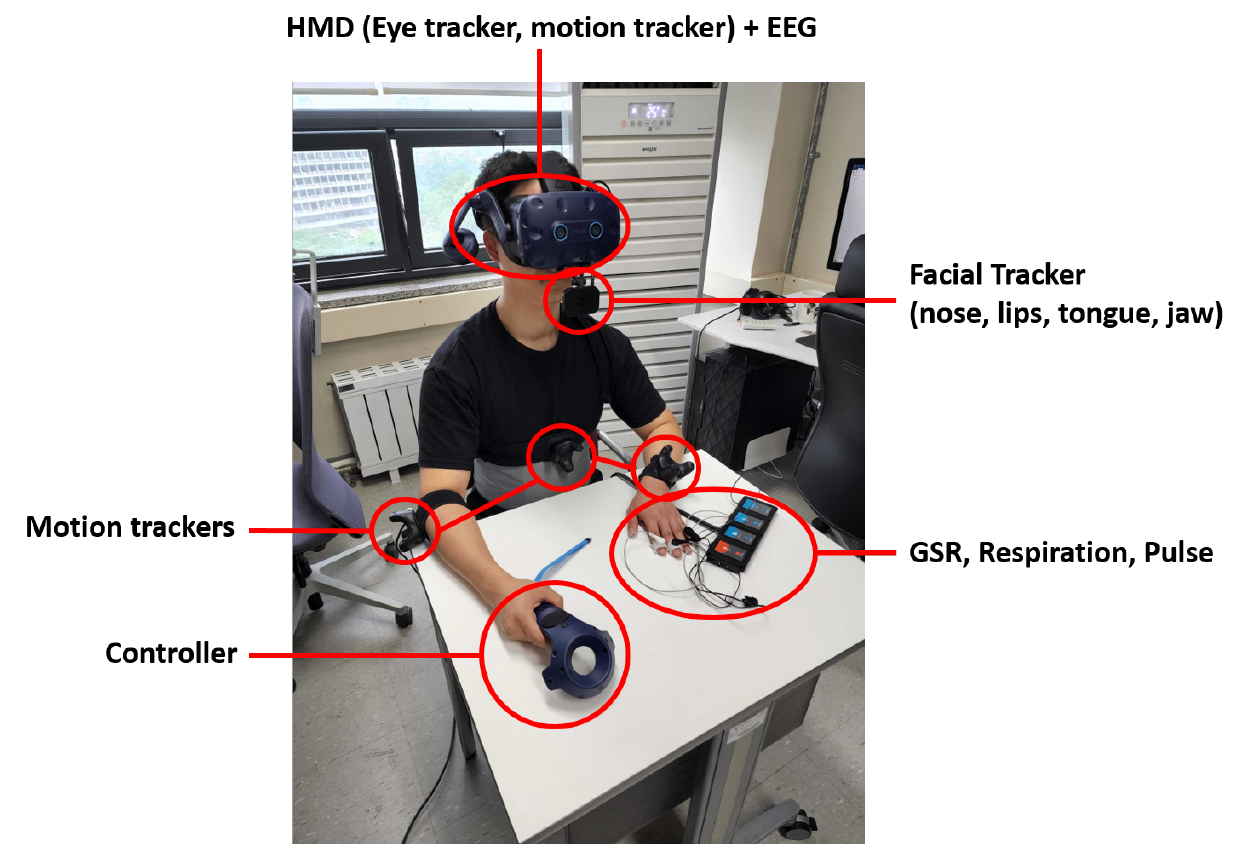
Figure 3. Sensors used in the embodiment